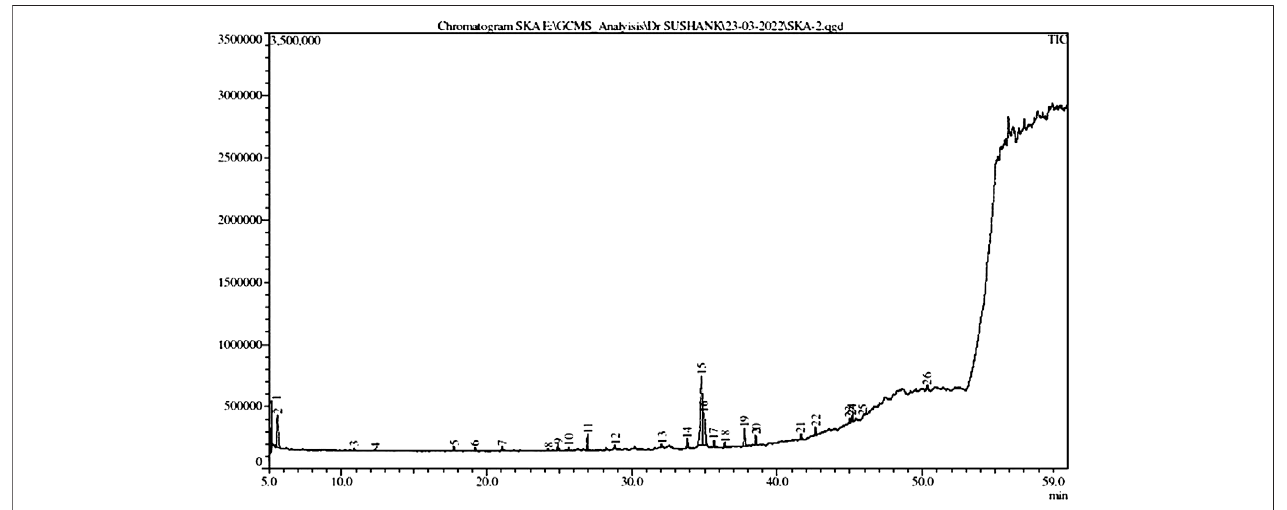
FIGURE 1 | GC-MS chromatogram of the ethanolic extract of Adenium obesum leaves.